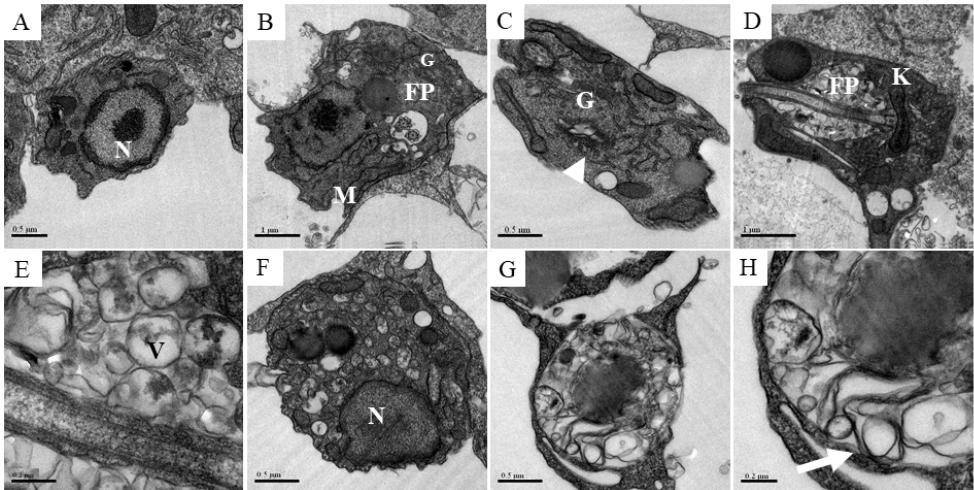
Figure 6. Ultrastructural analysis of amastigotes after the treatment with compound 2 . Peritoneal macrophages from BALB/c mice were infected with stationary phase L. amazonensis promastigotes and treated with compound 2 at 6 µ M during 24 and 48 h. ( A , B ) Control amastigotes showing normal organelles, such as nuclei, mitochondria, flagellar pocket and Golgi. ( C , D ) Amastigotes treated with compound 2 during 24 h presenting the opening of Golgi (arrowhead) and vesicle accumulation inside the flagellar pocket, respectively. ( E ) Zoomed image of vesicles inside the flagellar pocket highlighting the double and multiple membrane formation. ( F , G ) Increased accumulation of cytoplasmic vesicles in amastigotes treated with compound 2 during 48 h. ( H ) Zoomed image showing a myelin-like figure in the cytoplasm of an amastigote (arrow). N, nuclei; M, mitochondria; FP, flagellar pocket; G, golgi; K, kinetoplast; V, vacuole.